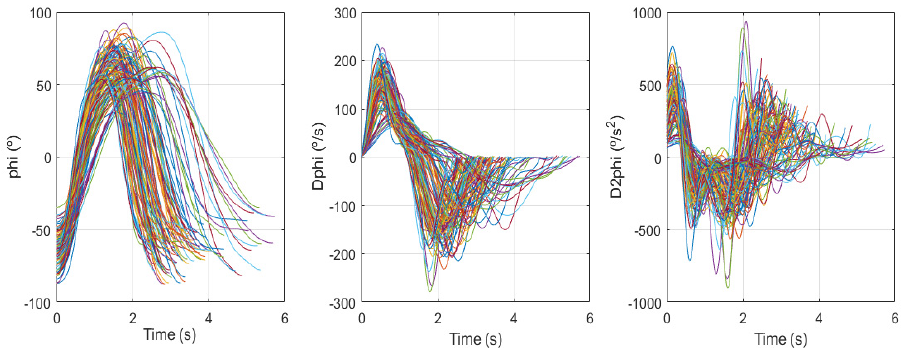
Figure 2. Absolute time-scale curves for angles (phi), velocities (Dphi), and accelerations (D2phi). To better appreciate the detail of the curves, only a quarter of the curves used in the analysis have been drawn, which have been chosen at random.